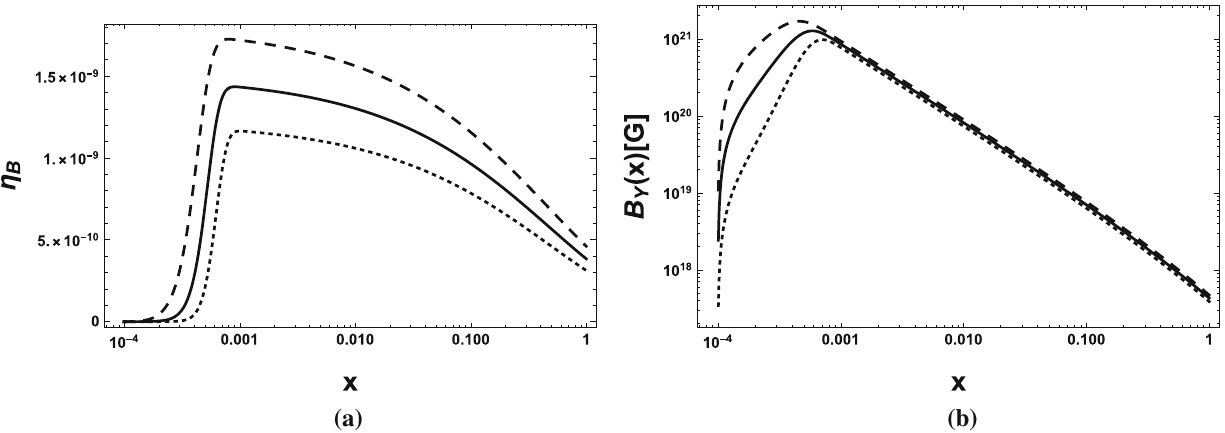
Fig. 3 Timeplotsof: a thebaryonasymmetry η B ,and b thehypermag- netic field amplitude B Y , for various values of the time of fluctuations. The initial conditions are: k = 10 − 7 , B